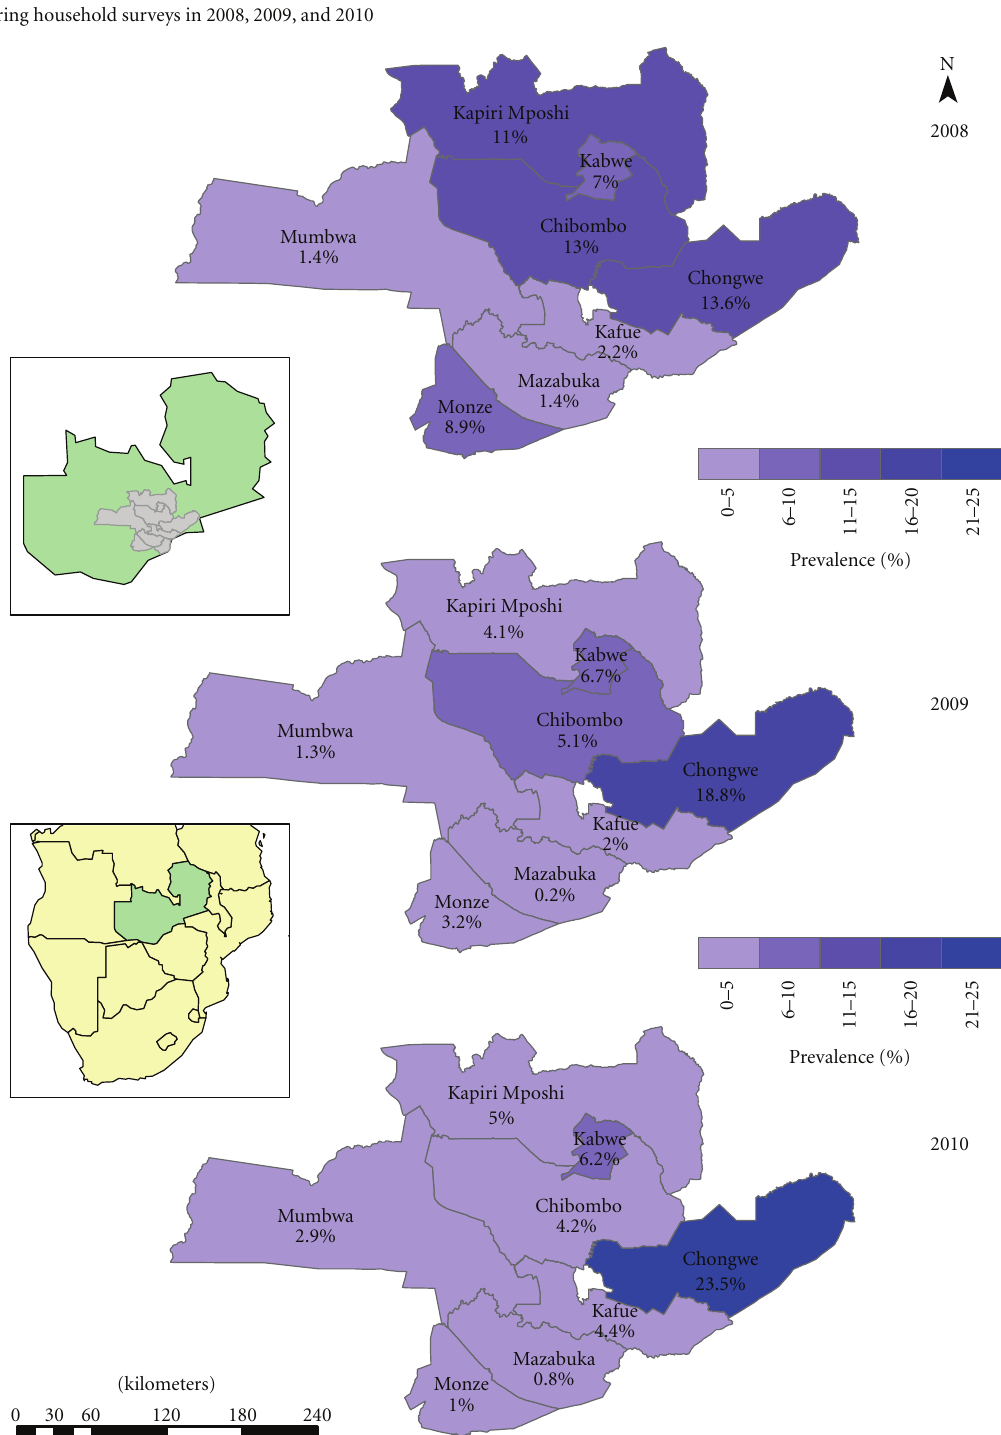
Figure 3: Prevalence of infection with P. falciparum in children 1 to < 15 years as observed during the annual parasitaemia surveys from 2008 to 2010 by